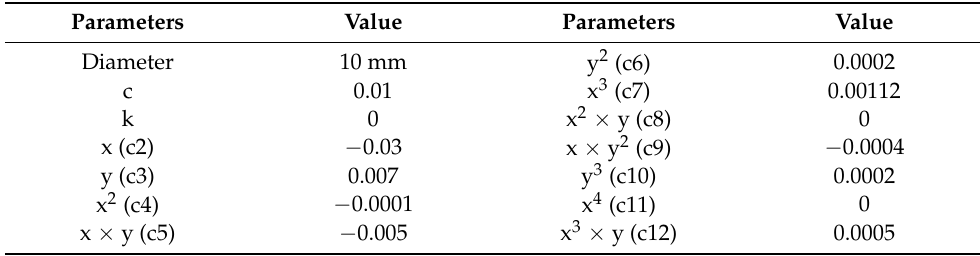
Table 1. Surface shape parameters.